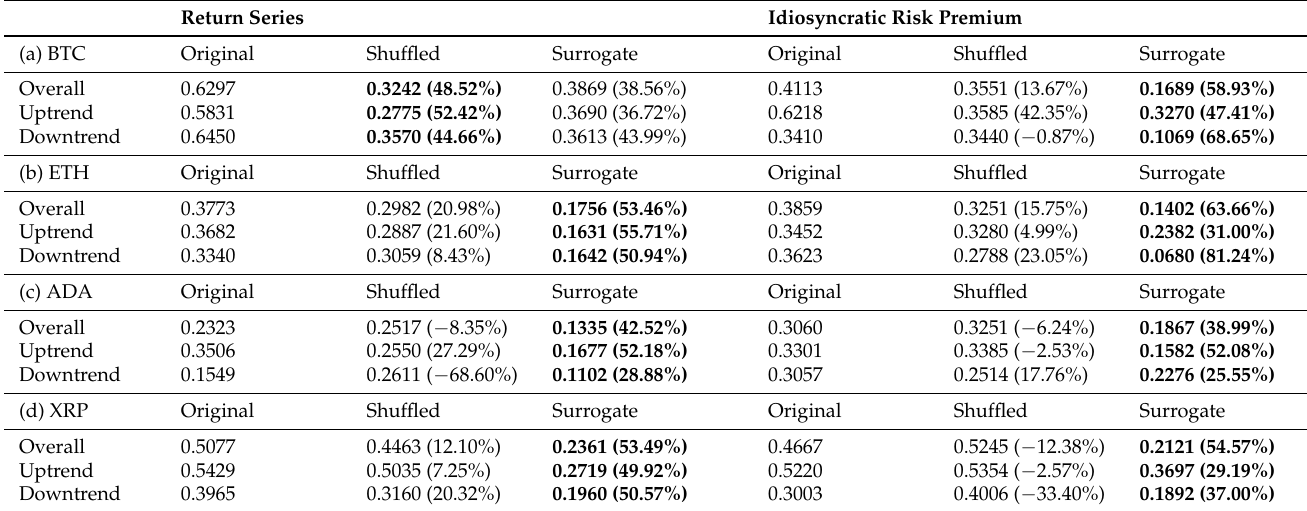
Table 1. ∆ H of the original, shuffled, and surrogate series of